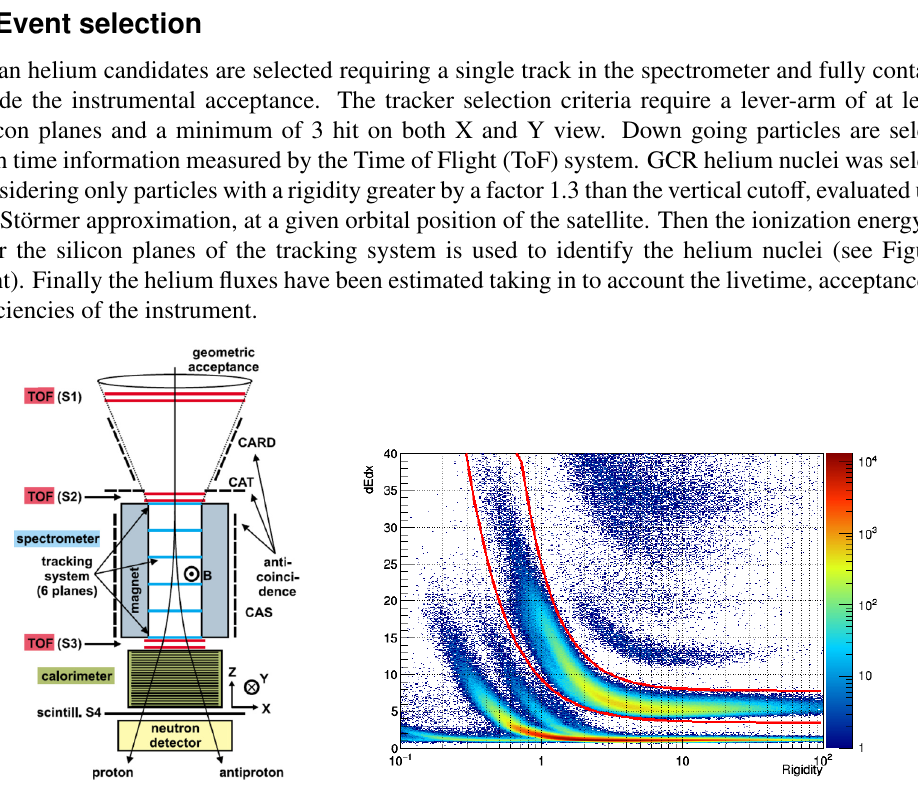
Figure 1. On the left: a schematic view of the PAMELA detector [17], [18]. On the right plot: the ionization energy loss distribution measured by the tracker as a function of rigidity. The region inside the two red curves represents the helium band considered for the selection